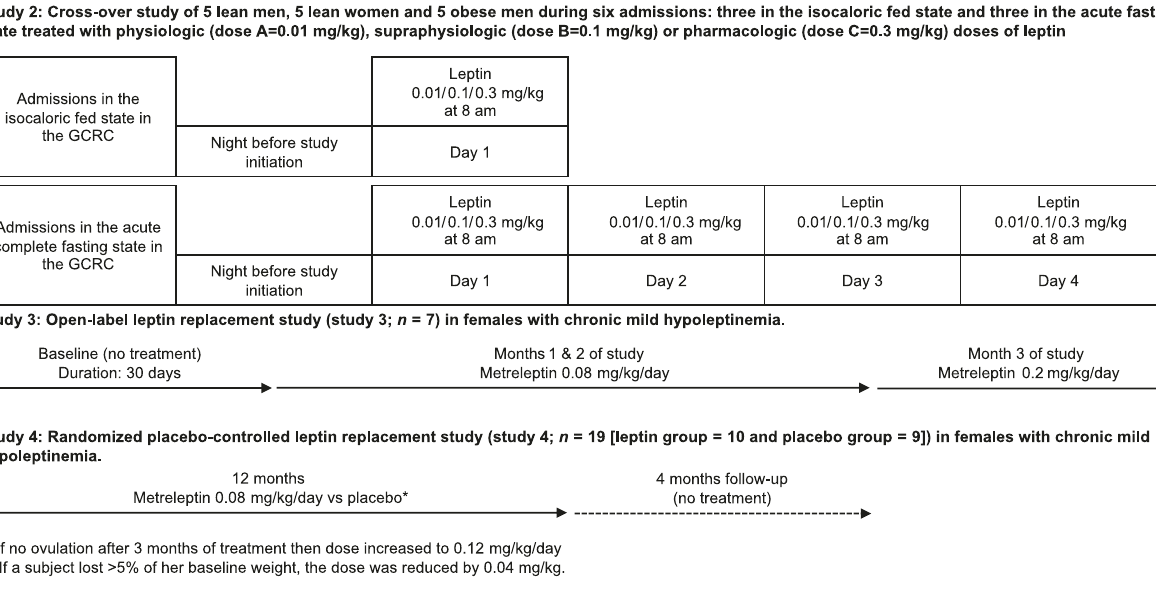
Fig. 1 Schematic representation of the study designs of the four clinical studies. Study 1: Eight healthy lean men and seven healthy lean women were studied under three separate Clinical Research Center (CRC)-based conditions for 72 h: one under isocaloric fed state conditions (normoleptinemia) and two during complete fasting state conditions (induced hypoleptinemia) scheduled in a random order and in a double-blind fashion with administration of physiologic replacement leptin doses (fasting + leptin) or placebo (fasting + placebo). Study 2: Five lean men, fi ve men with obesity, and fi ve lean women participated in three fed-normoleptinemic and three fasting-induced hypoleptinemic studies, which were conducted in the CRC, with leptin administration at three different doses (Dose A = 0.01 mg/kg, Dose B = 0.1 mg/kg, Dose C = 0.3 mg/kg). Study 3: Open-label long-term leptin treatment in mildly hypoleptinemic women. Study 4: Placebo-controlled long-term leptin treatment in mildly hypoleptinemic